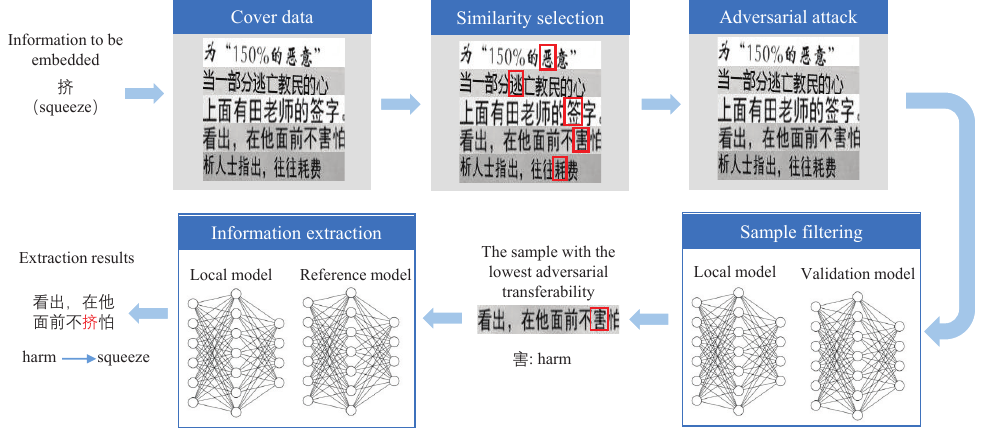
Figure 3. The framework of the character-level text image steganography method based on adversar- ial attacks. The red boxes are the characters we selected for modification. We have embedded the character squeeze in the character